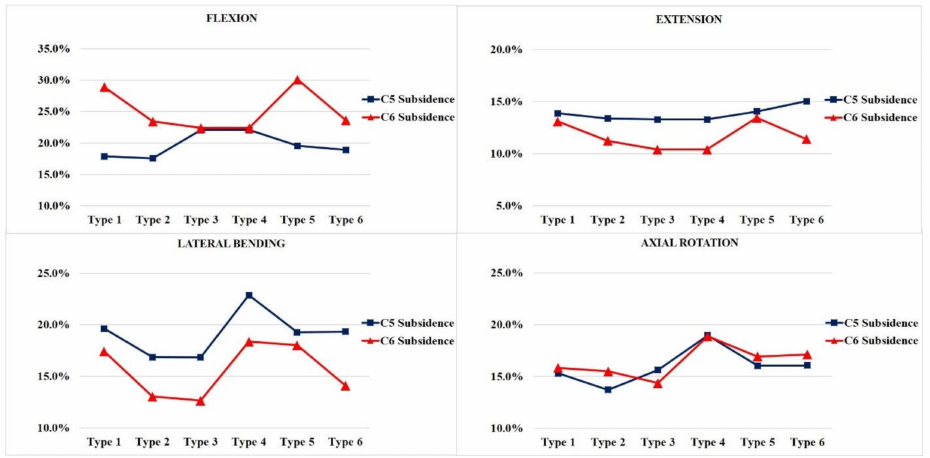
Figure 4. The subsidence risk analysis of the allograft spacers on C5 and C6. Type 1: all LMS, Type 2: all PS, Type 3: left (Lt) PS and right (Rt) LMS, Type 4: Lt LMS and Rt PS, Type 5: upper PS and lower LMS, and Type 6: upper LMS and lower